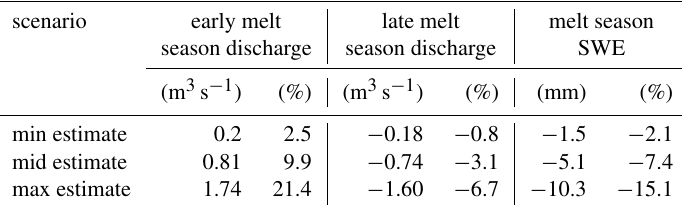
Table 3. Average change in discharge during the early (22 March to 29 May) and late (30 May to 10 August) melt seasons of min, mid, and max estimates and average change in SWE during the melt season (22 March to 10 August) compared to the no-ARF